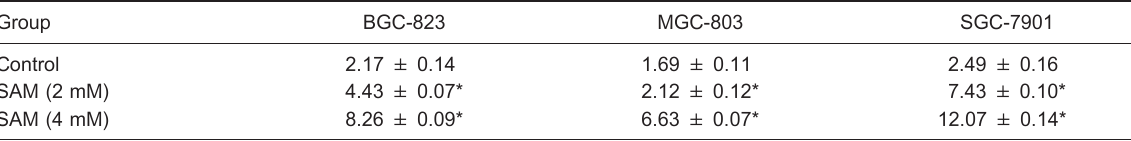
*P , 0.05, compared to control (Dunnett t